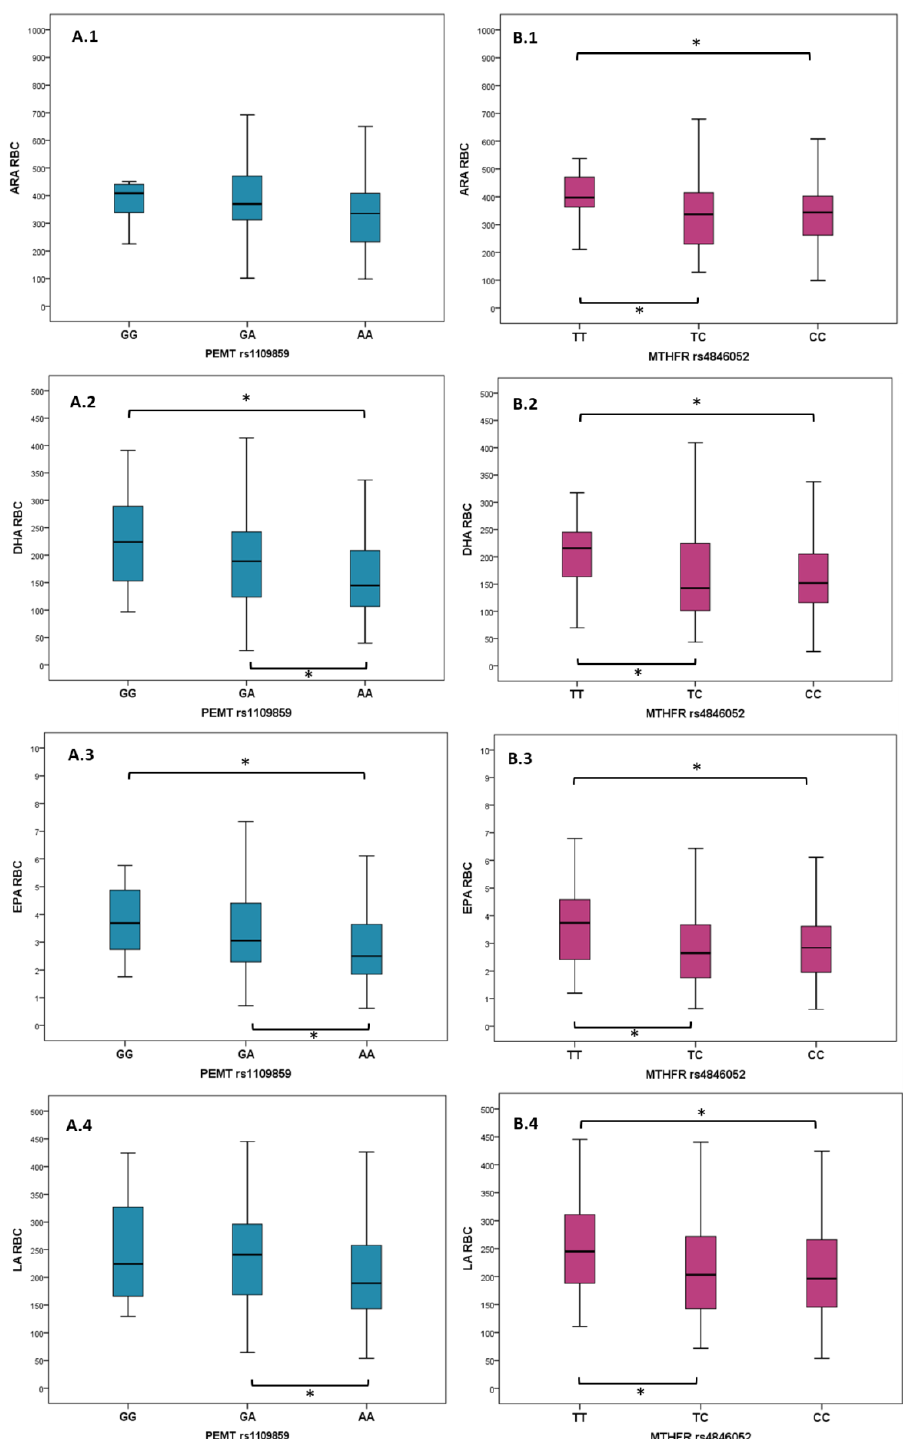
Figure 1. Distribution of PUFA species grouped by PEMT rs1109859 ( A ) and MTHFR rs4846052 genotypes ( B ). Mann – Whitney U test was used to assess statistical significance between groups. Significant differences are marked with *, and the brackets indicate the two groups for which these differences were identified. Horizontal lines, within each boxplot, indicate minimum, first quartile (Q1), median, third quartile (Q3), and maximum. Legend: ARA — arachidonic acid, DHA — docosahexaenoic acid, EPA — eicosapentaenoic acid, LA — linoleic acid, RBC — red blood cell membrane; MTHFR — methylenetetrahydrofolate reductase; PEMT — phosphatidylethanolamine N - methyltransferase.